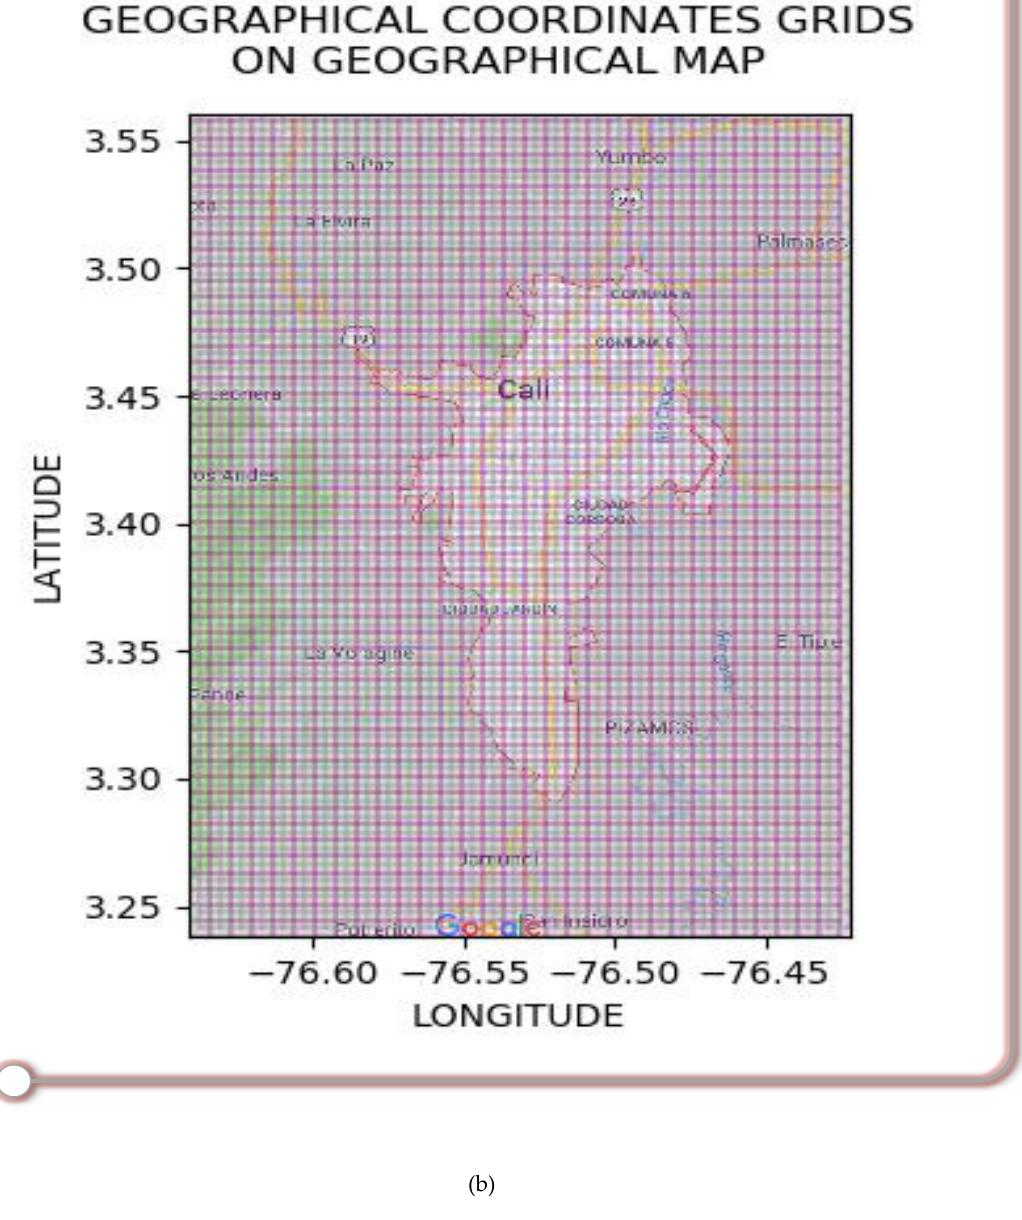
Figure 3. Grid system capture: (a) A 25% double grid; (b) grid system overlapping the geographical map of the observation area. map of the observation